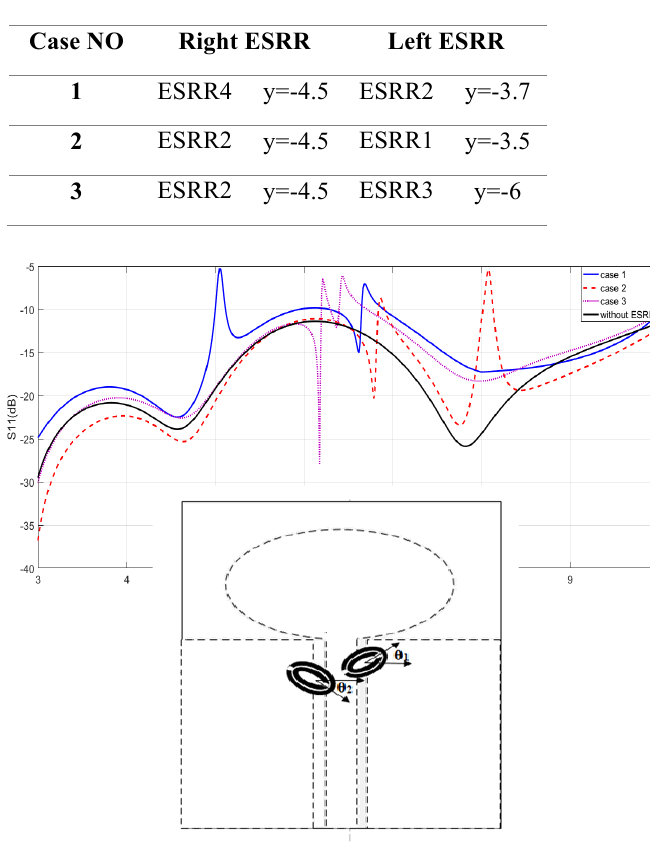
Table 5: The different ESRR combinations and positions, values are in mm.